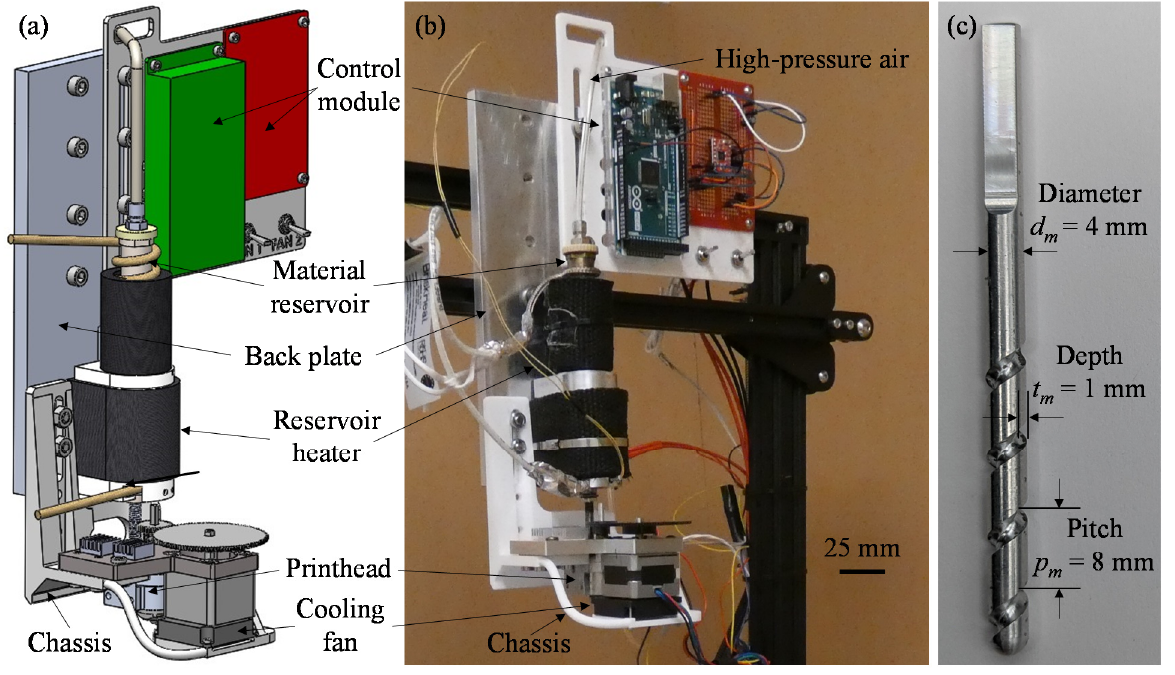
Figure 6. ( a ) Schematic and ( b ) setup of the artificial muscle material extrusion system. ( c ) Fluted mandrel with key dimensions. mandrel with key